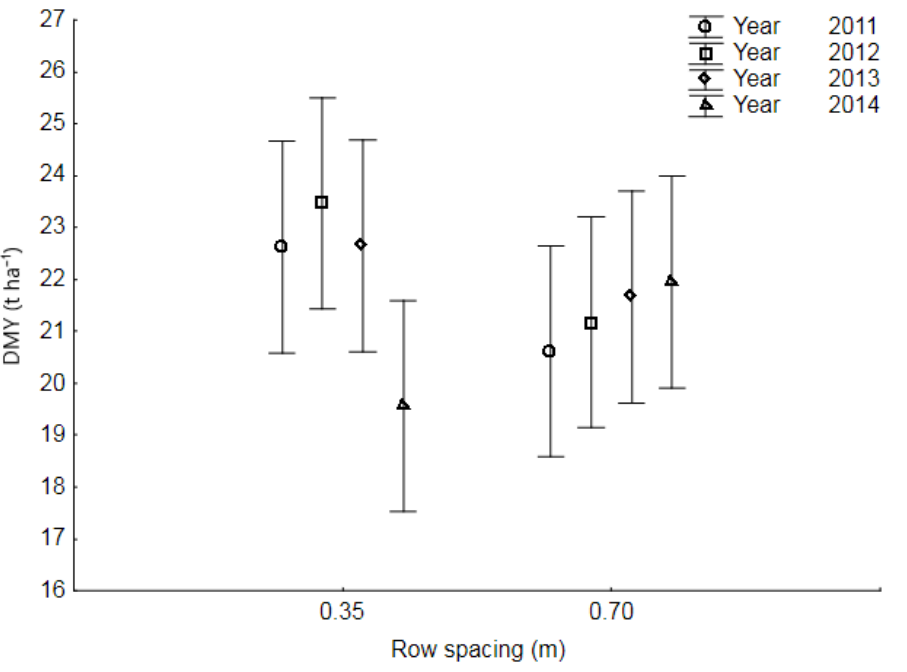
Figure 2. Dry matter yield (DMY) for two row spacings (0.70 m and 0.35 m) at a plant density of Figure 2. Dry ma tt er yield (DMY) for two row spacings (0.70 m and 0.35 m) at a plant density of 92,000 plants ha − 1 in 2011–2014 ( p = 92,000 plants ha − 1 in 2011–2014 ( p = 0.095).